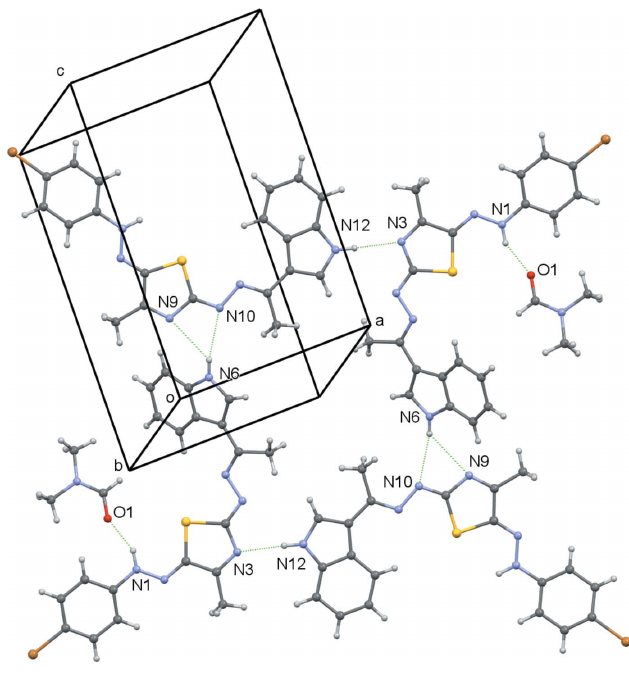
Figure 2 A segment of the crystal structure showing hydrogen-bonding contacts as dotted lines.